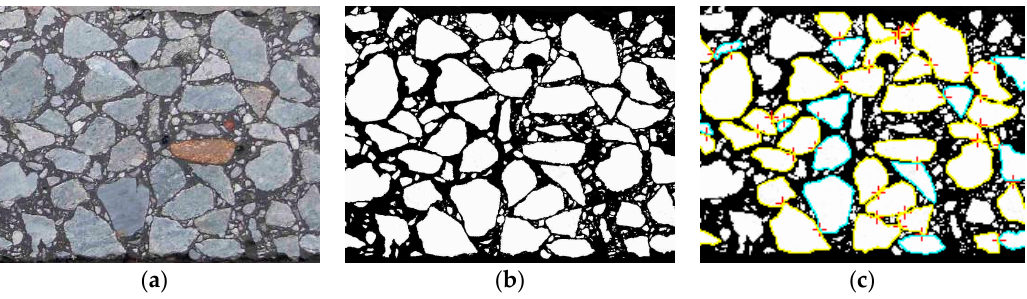
Figure 2. Image processing and contact analysis. ( a ) Original image; ( b ) binary image; and ( c ) spatial distribution of contact points.